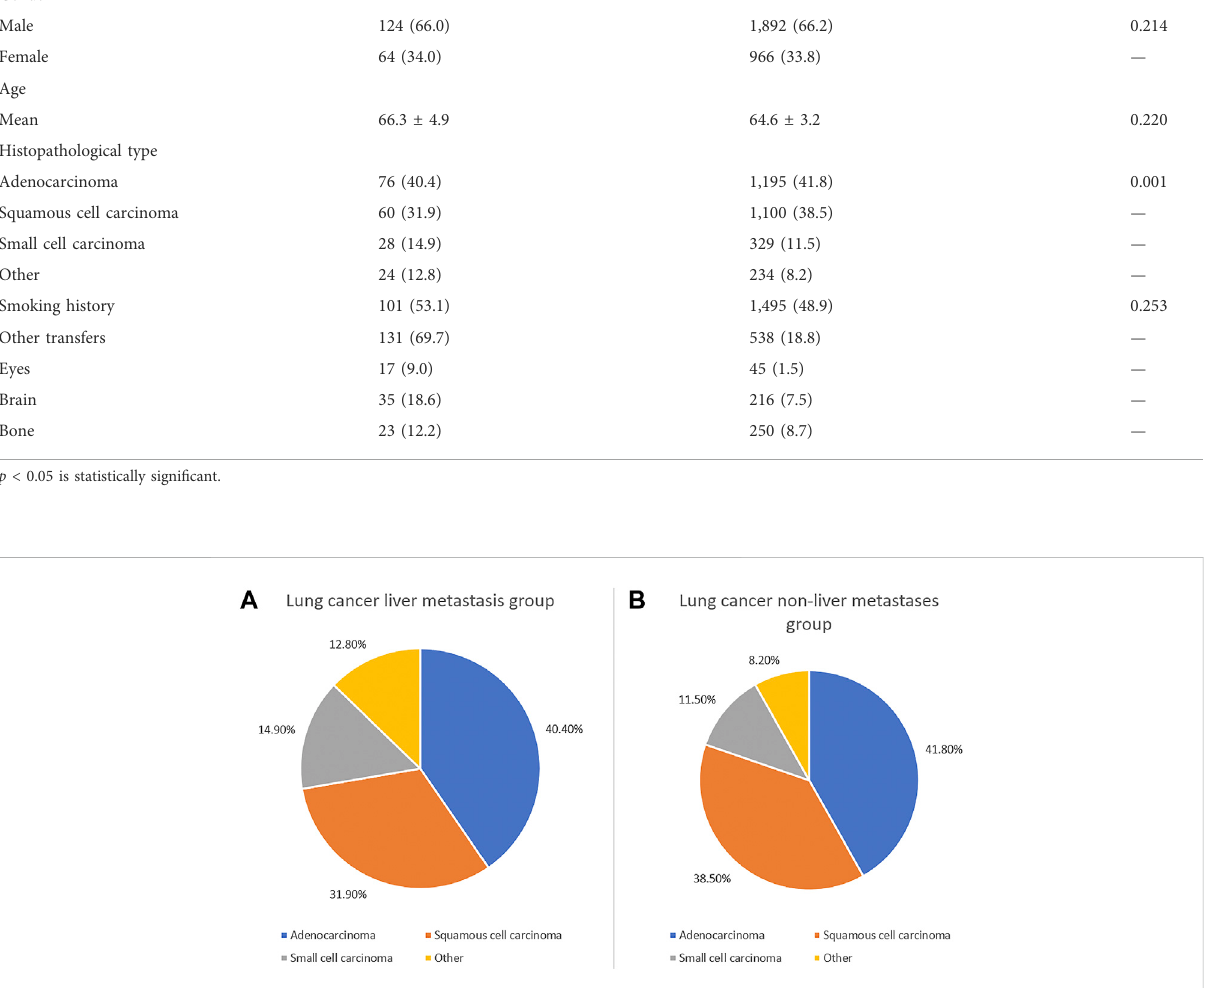
FIGURE 1 Clinical characteristics of elderly lung cancer patients with liver metastasis and without liver metastasis. The clinical characteristics of elderly patients with lung cancer liver metastasis (A) and without liver metastasis (B)